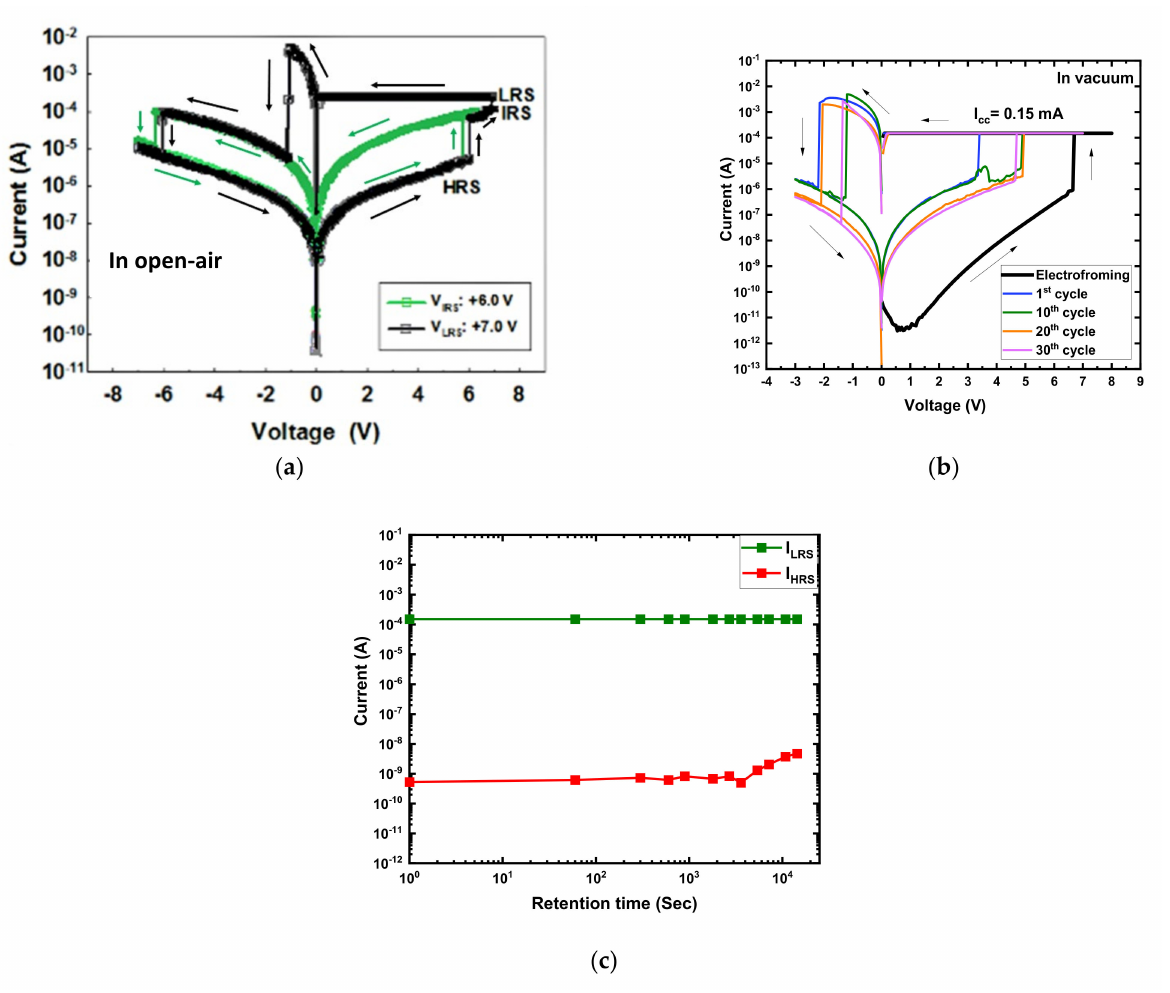
Figure 2. Typical I–V characteristics of Au/Ni/SiO x N y /p + -Si at room temperature ( a ) in open air [21], and ( b ) in a vacuum; ( c ) data retention characteristics of the device in a vacuum at 300 K. I–V measurement of the devices was carried out when the chamber was in a vacuum (<10 − 3 torr) at 300 K to investigate the effects of the operating environment on the device